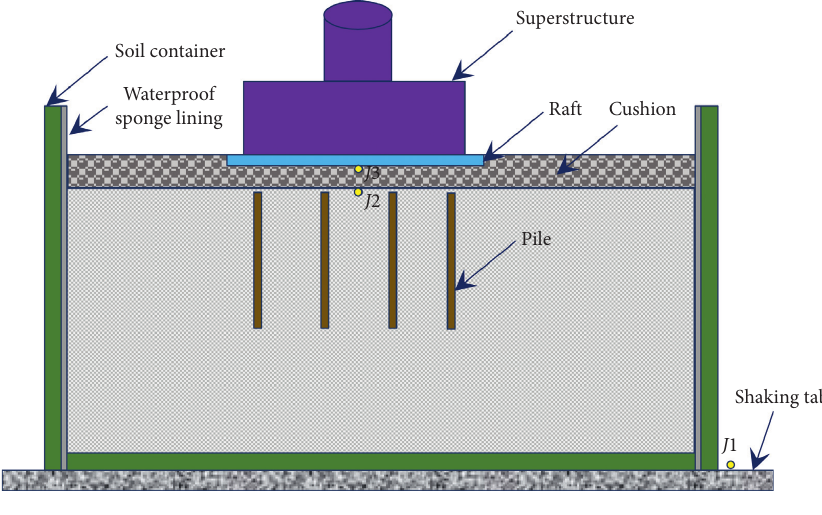
Figure 5: Schematic illustration of the test model and measurement point configuration (acceleration was measured at three points).